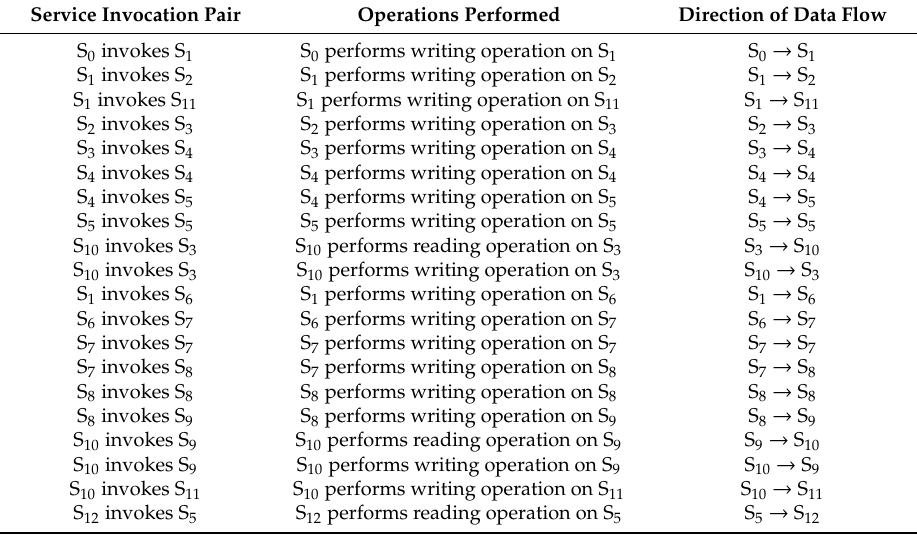
Table 9. Service invocation elements in network reception and dispatch